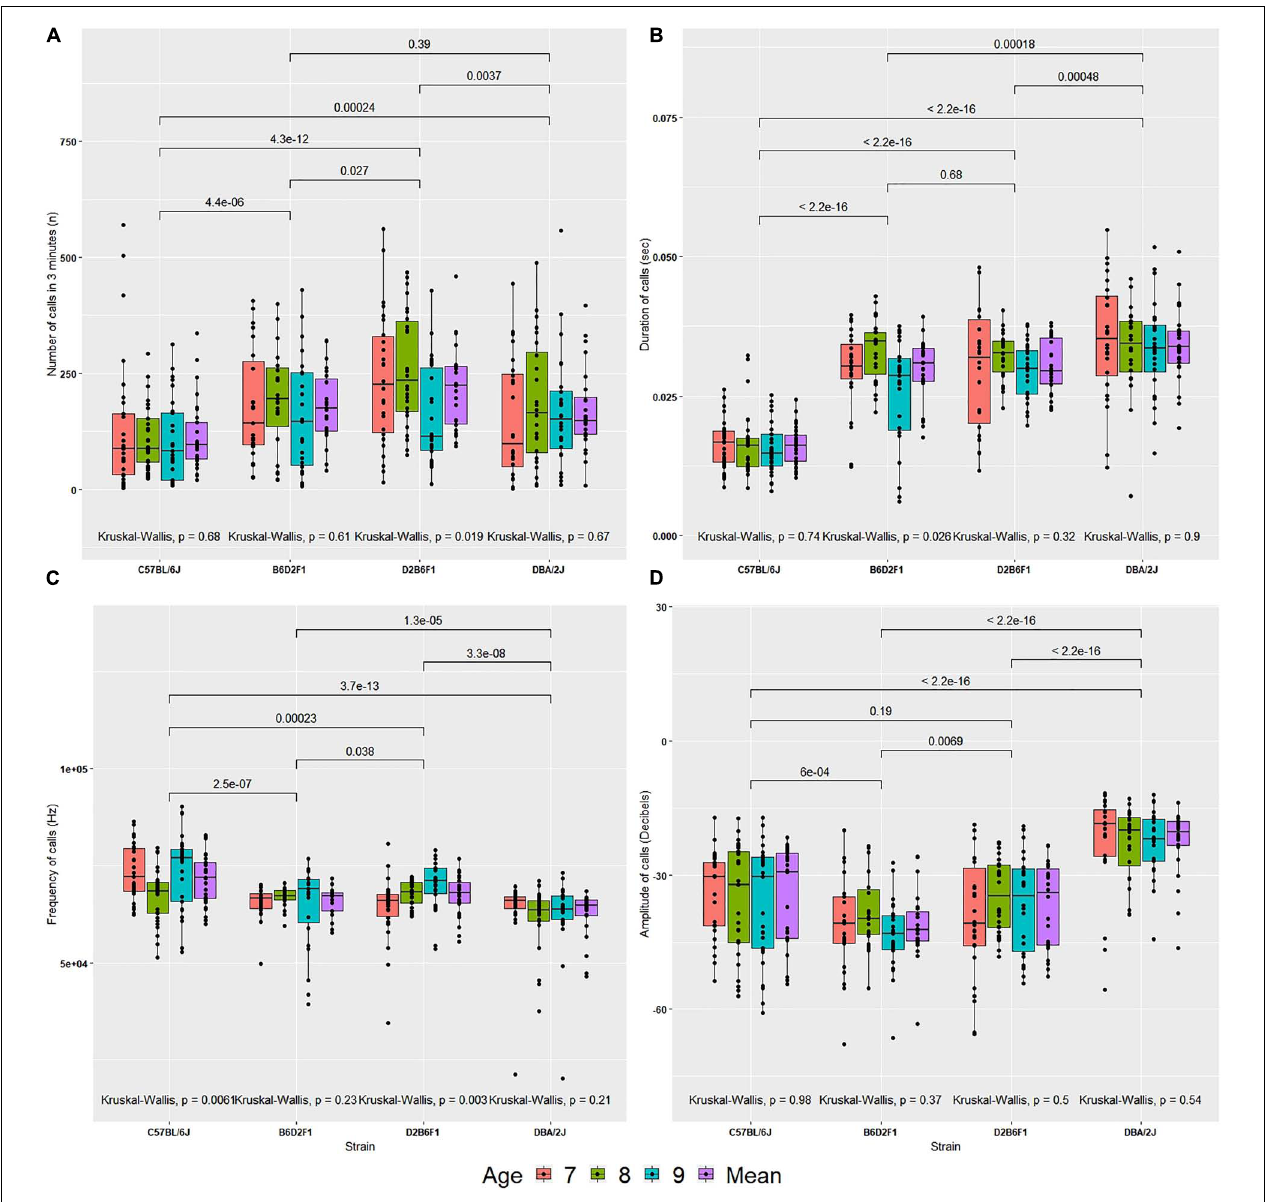
FIGURE 2 | Values for four quantitative traits in the diallel cross (A–D) on postnatal days 7, 8, and 9, and the mean across days. (A) Number of calls, (B) duration of calls, (C) peak frequency of calls, (D) peak amplitude of calls. The bars above the graph show the significance of Wilcoxon test comparisons between the strains. Kruskal–Wallis significance values are shown below the graph for comparisons between age within each strain.